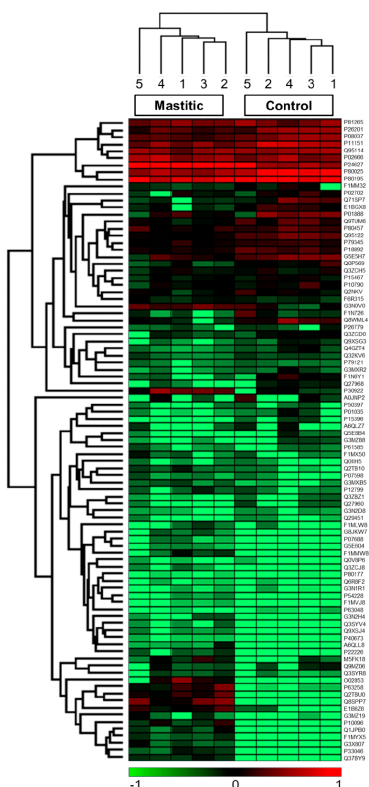
lower levels, respectively, in mastitic cows compared with the healthy control cows.